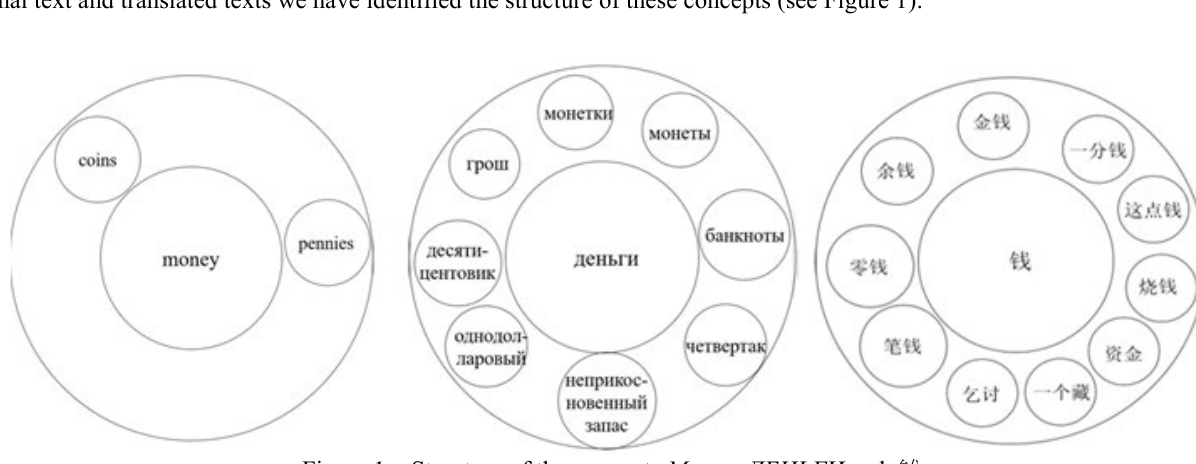
Figure 1 – Structure of the concepts Money, ДЕНЬГИ and